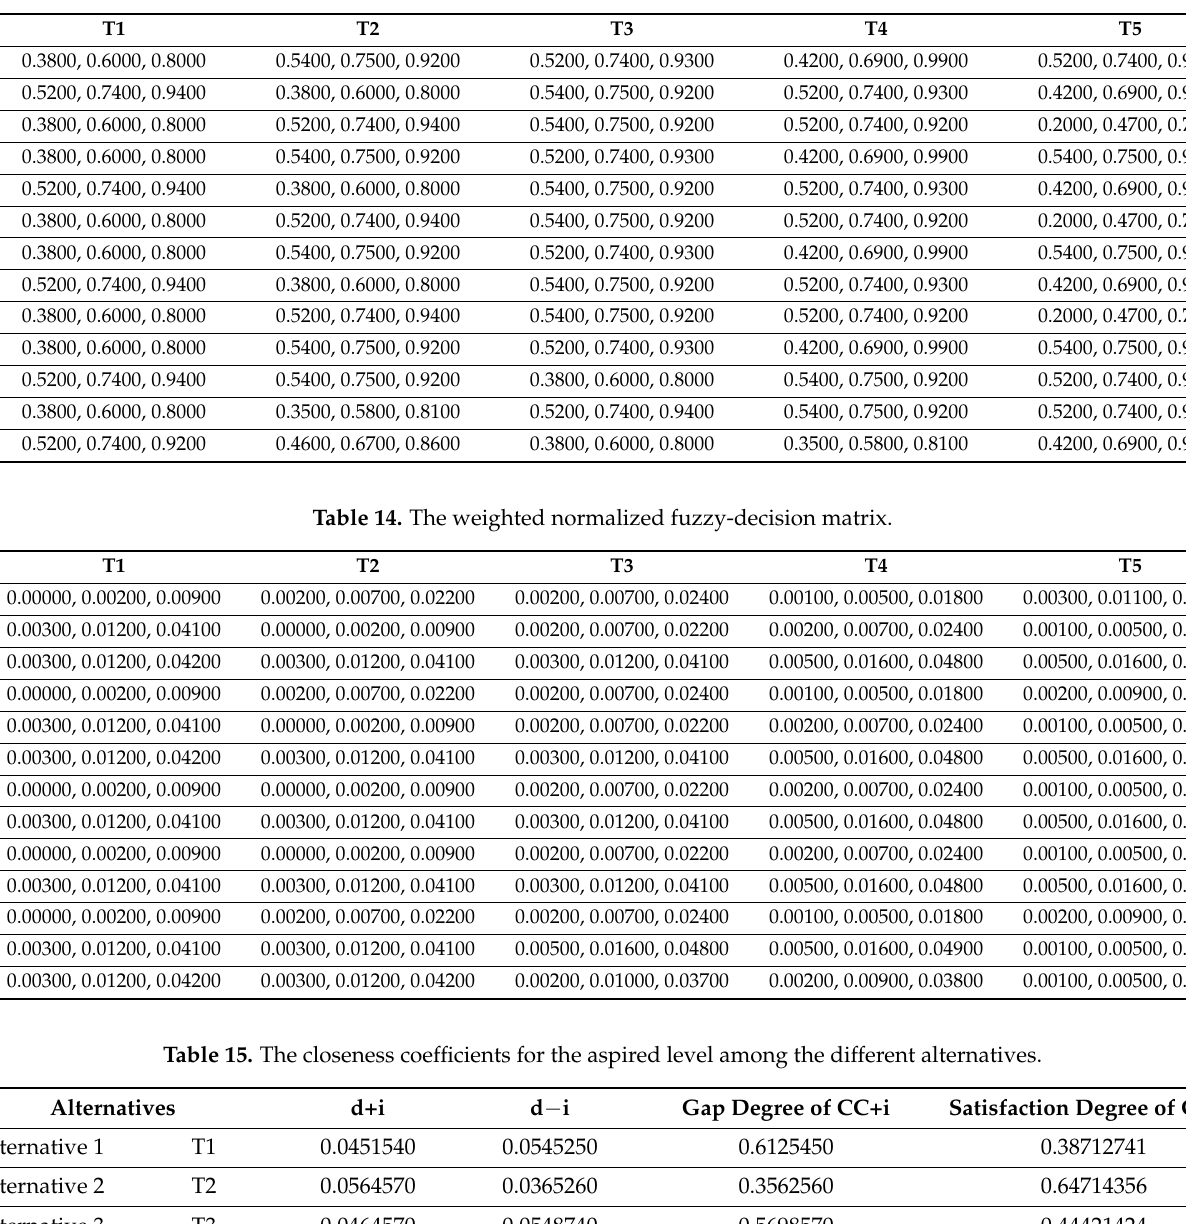
Table 13. The normalized fuzzy-decision matrix.